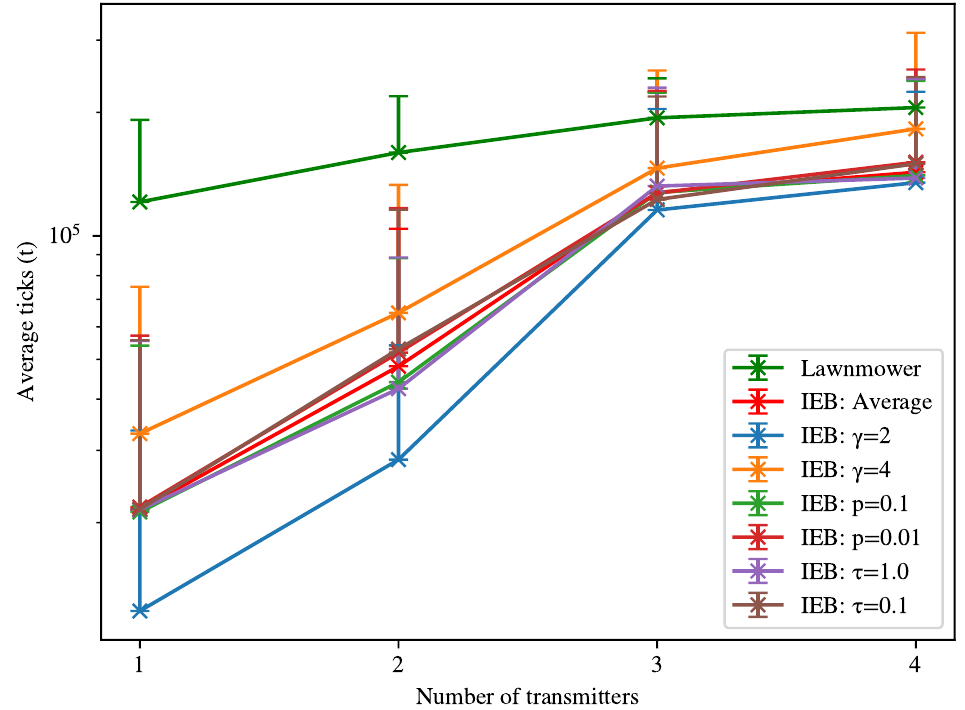
Figure 2. Time taken to find all transmitters within environment with varied transmitter properties. Error bar indicates σ 2 standard